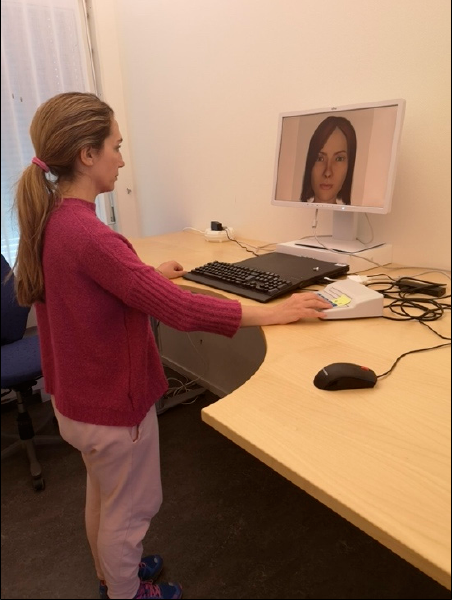
Figure 1. Experiment set-up.